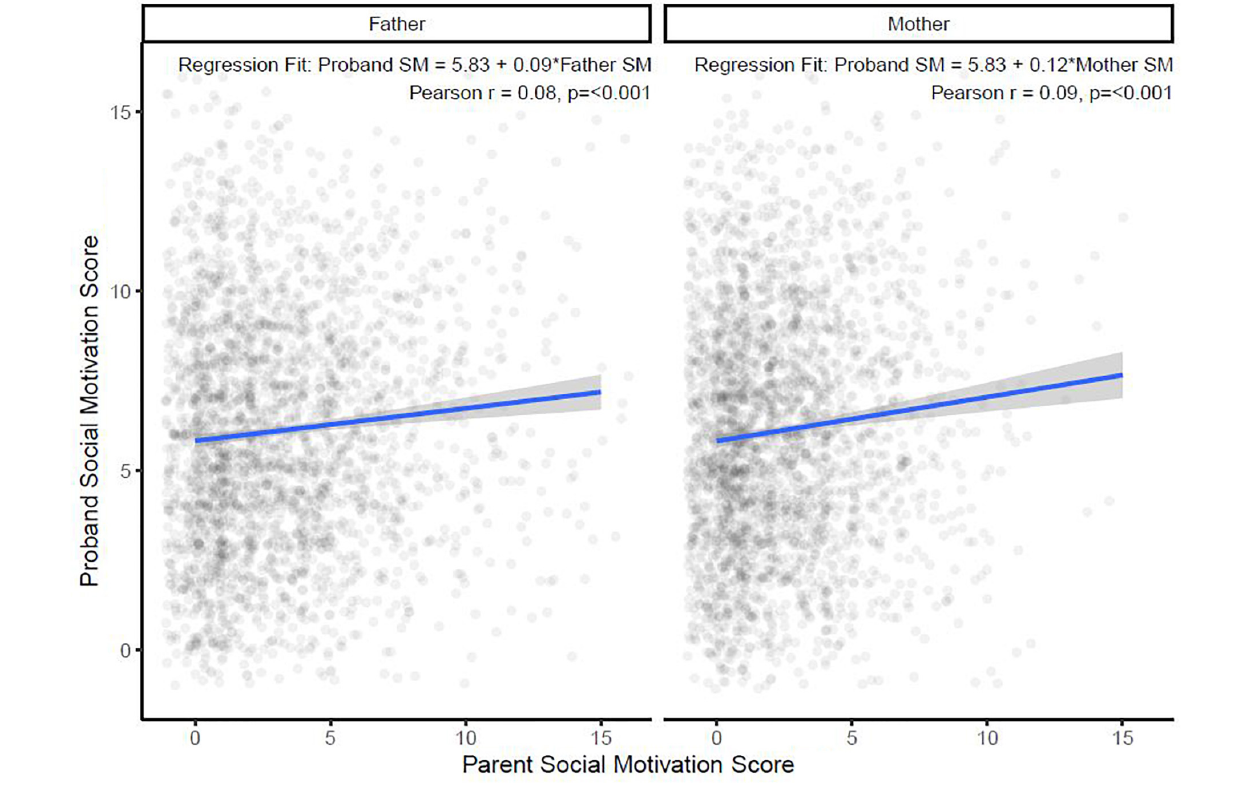
Frontiers in Neuroscience |